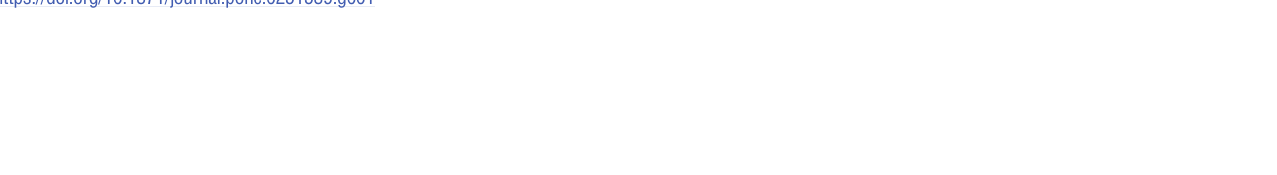
PLOS ONE | https://doi.org/10.1371/journal.pone.0251539 May 6, 2021 2 /